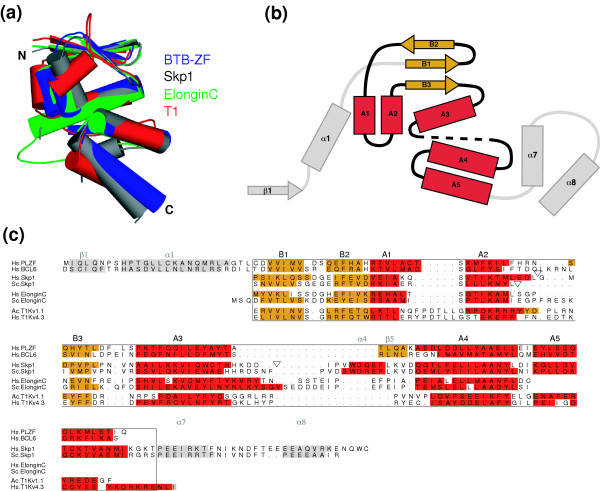
Comparison of structures containing the BTB fold. (a) Superposition of the BTB core fold from currently known BTB structures. The BTB core fold (approximately 95 residues) is retained across four sequence families. The BTB-ZF, Skp1, ElonginC and T1 families are represented here by the domains from Protein Data Bank (PDB) structures 1buo:A, 1fqv:B, 1vcb:B, 1t1d:A. (b) Schematic of the BTB fold topology. The core elements of the BTB fold are labeled B1 to B3 for the three conserved β-strands, and A1 to A5 for the five α-helices. Many families of BTB proteins are of the 'long form', with an amino-terminal extension of α1 and β1. Skp1 proteins have two additional α-helices at the carboxyl terminus, labeled α7 and α8. The dashed line represents a segment of variable length that is often observed as strand β5 in the long form of the domain, and as an α-helix in Skp1. (c) Structure-based multiple sequence alignment of representative BTB domains from each of the BTB-ZF, Skp1, ElonginC and T1 families. The core BTB fold is boxed. Secondary structure is indicated by red shading for α-helices and yellow for β-strands, with the amino- and carboxy-terminal extensions shaded in gray. The low complexity sequences, which are disordered in the Skp1 structures, are indicated by open triangles. See Figure 3 for the PDB codes for the corresponding sequences.